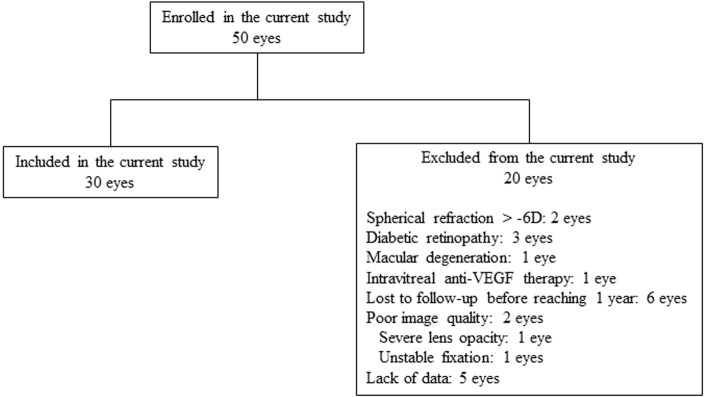
Flowchart showing the number of patients who were enrolled in this study.